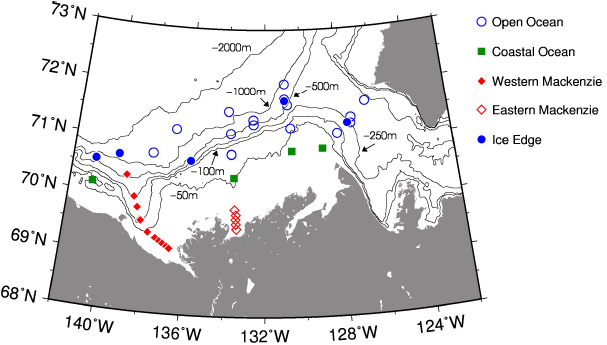
Fig. 1. The location of Malina optical stations color coded to show the western and eastern Mackenzie transects (red solid and open di- amonds, respectively), open-ocean and ice-edge stations (blue open and solid circles, respectively), and coastal stations (green